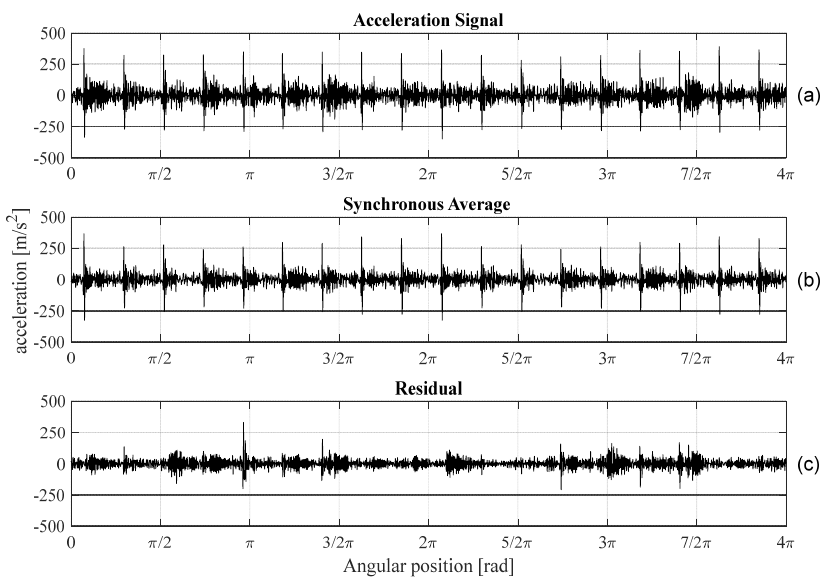
Figure 4. ( a ) Raw signal, ( b ) synchronous average, and ( c ) residual signal of the signal measured by sensor 1 for the standard pump (1500 r/min, 150 bar).